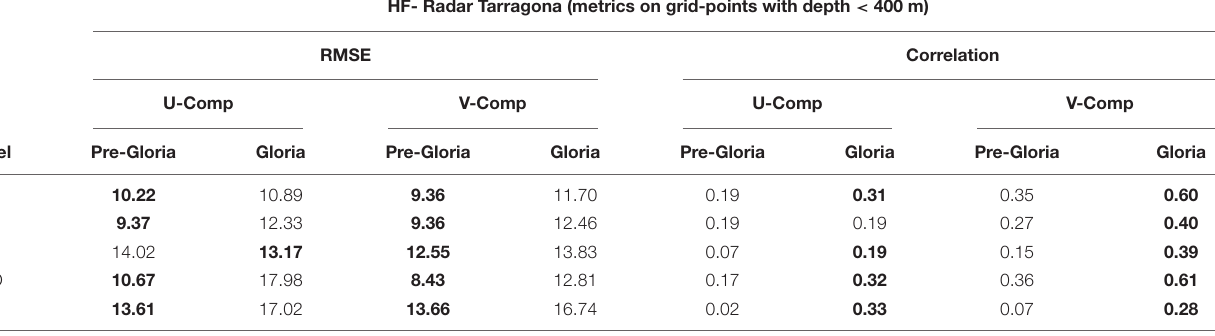
TABLE 3 | Model validation metrics (RMSE and correlation) for simulated surface currents (U and V components) when compared with HF Radar observations from two systems (Tarragona and Ibiza). HF- Radar Tarragona (metrics on grid-points with depth < 400